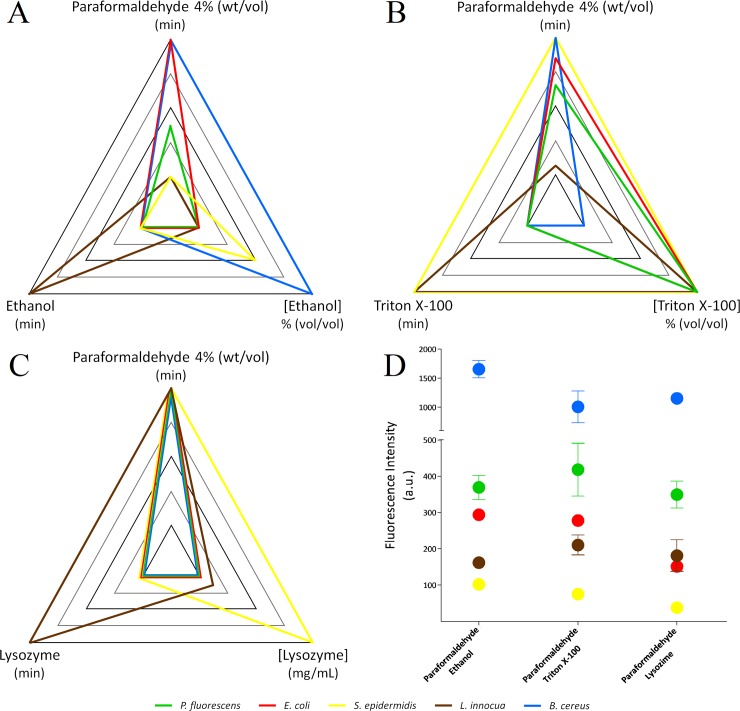
Optimum PNA-FISH fixation/permeabilization protocol and fluorescence intensity outcome obtained for each species.Radar chart representation in terms of level factors (-1 [inner vertices] to 1 [outer vertices]): A—Paraformaldehyde and ethanol; B—Paraformaldehyde and triton X-100; C—Paraformaldehyde and lysozyme. D—Average fluorescence intensity and error bars (standard deviation) of the confirmation experiment for the optimum fixation/permeabilization protocol for each species (P. fluorescens—green; E. coli—red; S. epidermidis—yellow; L. innocua—brown and B. cereus—blue).